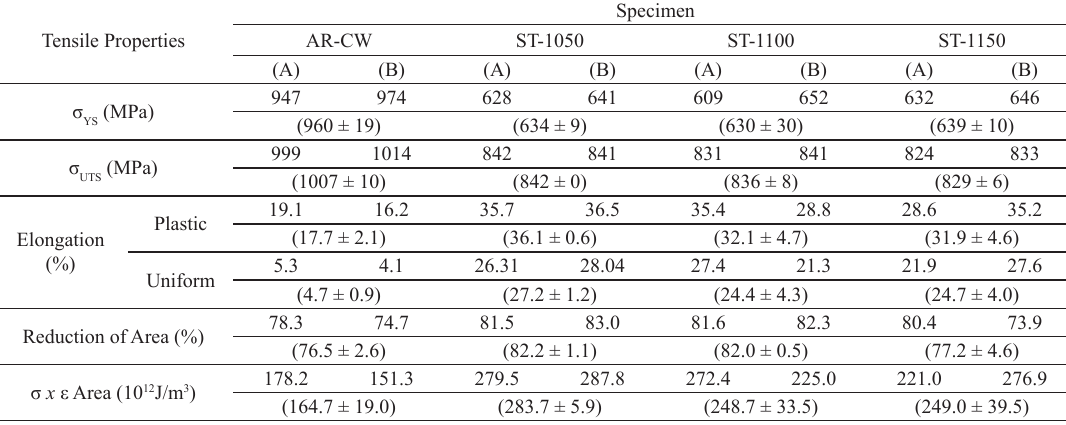
Figure 5. Average curves from tensile tests: (a) nominal stress (σ Table 5. Tensile properties (two tests per condition, average values are also